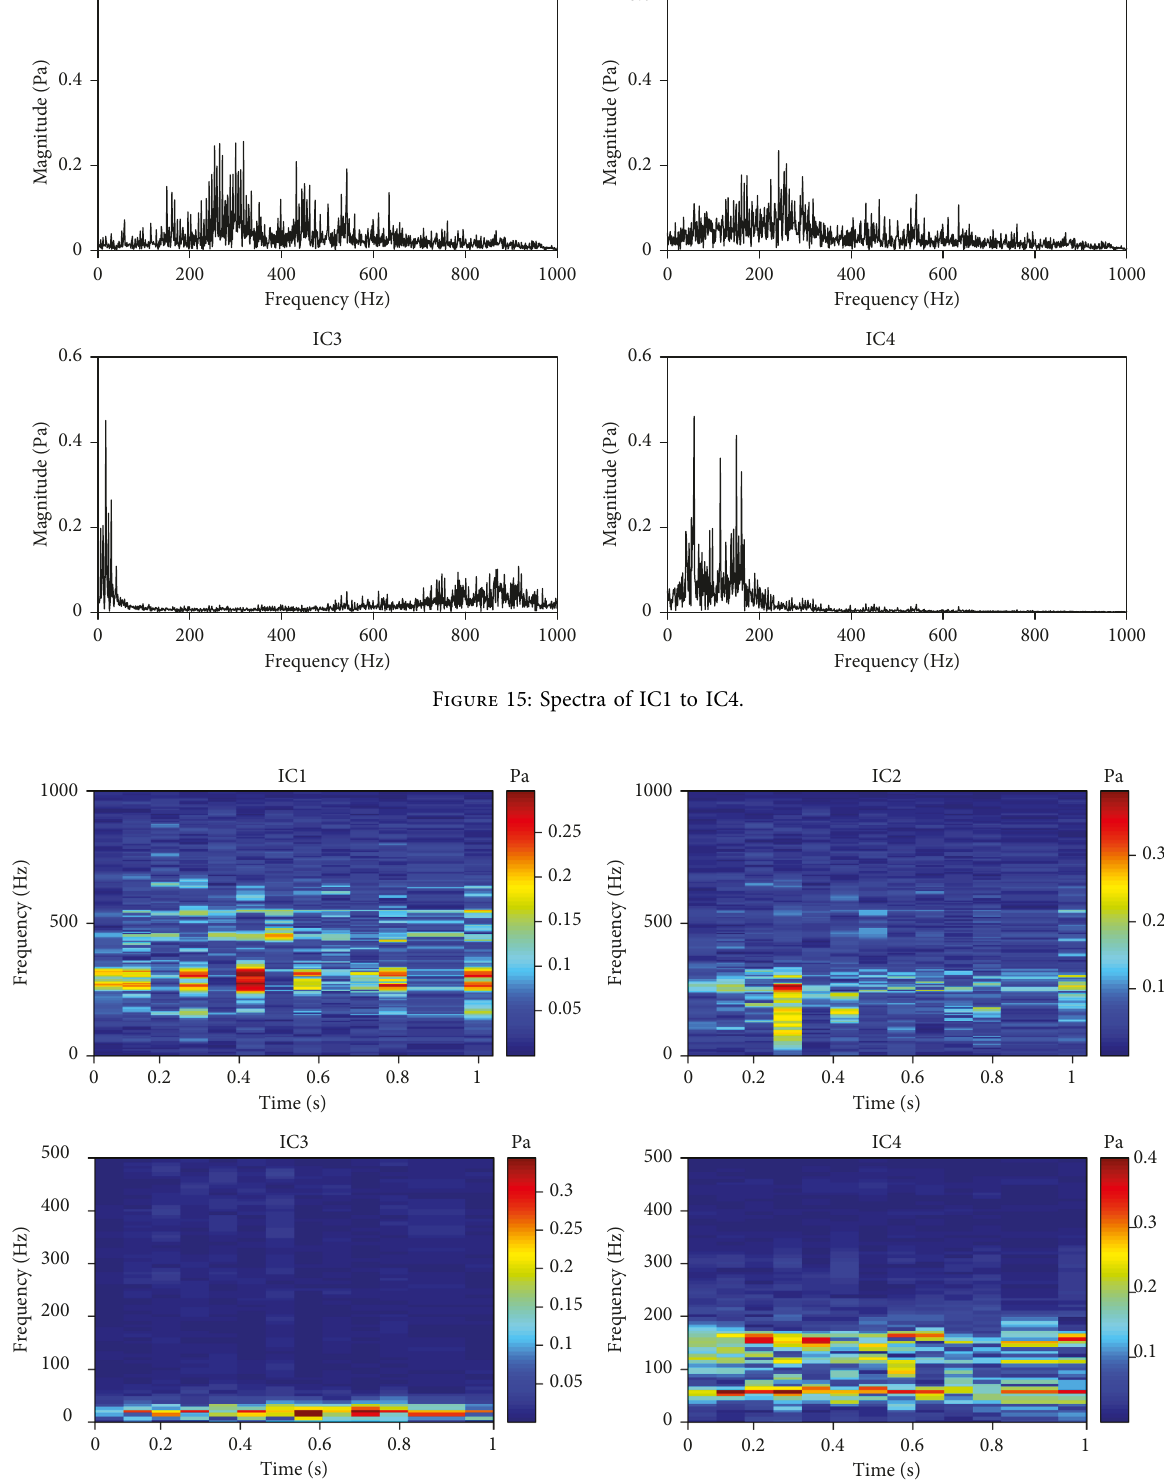
Figure 16: Spectrograms of IC1 to